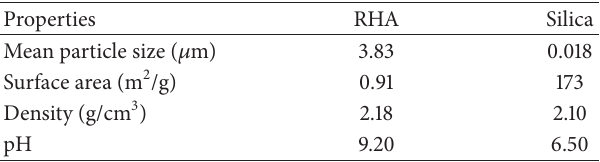
Table 2: Physical properties of rice husk ash (RHA) and silica. Table 3: Chemical compositions of RHA.